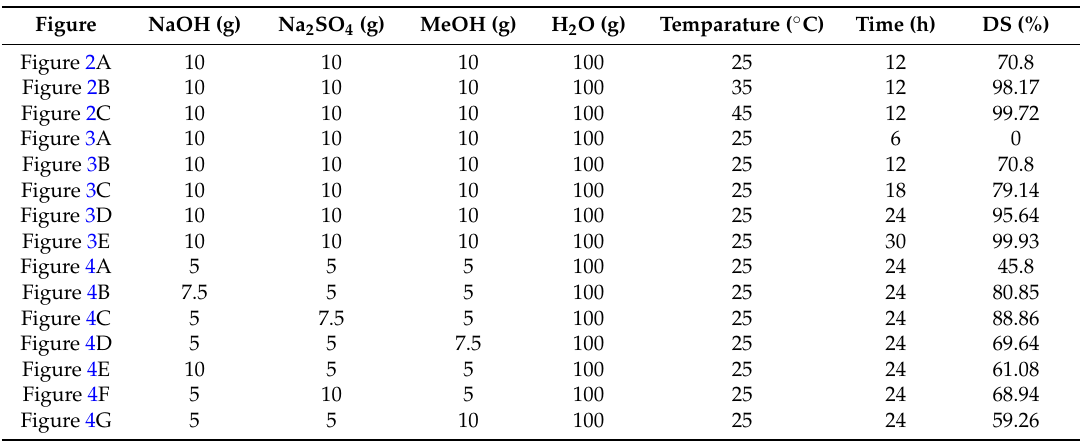
Table 2. The reagents and conditions employed in the heterogeneous saponification of PVAc nanofibers and the resulting degree of saponification. (DS: Degree of saponification).